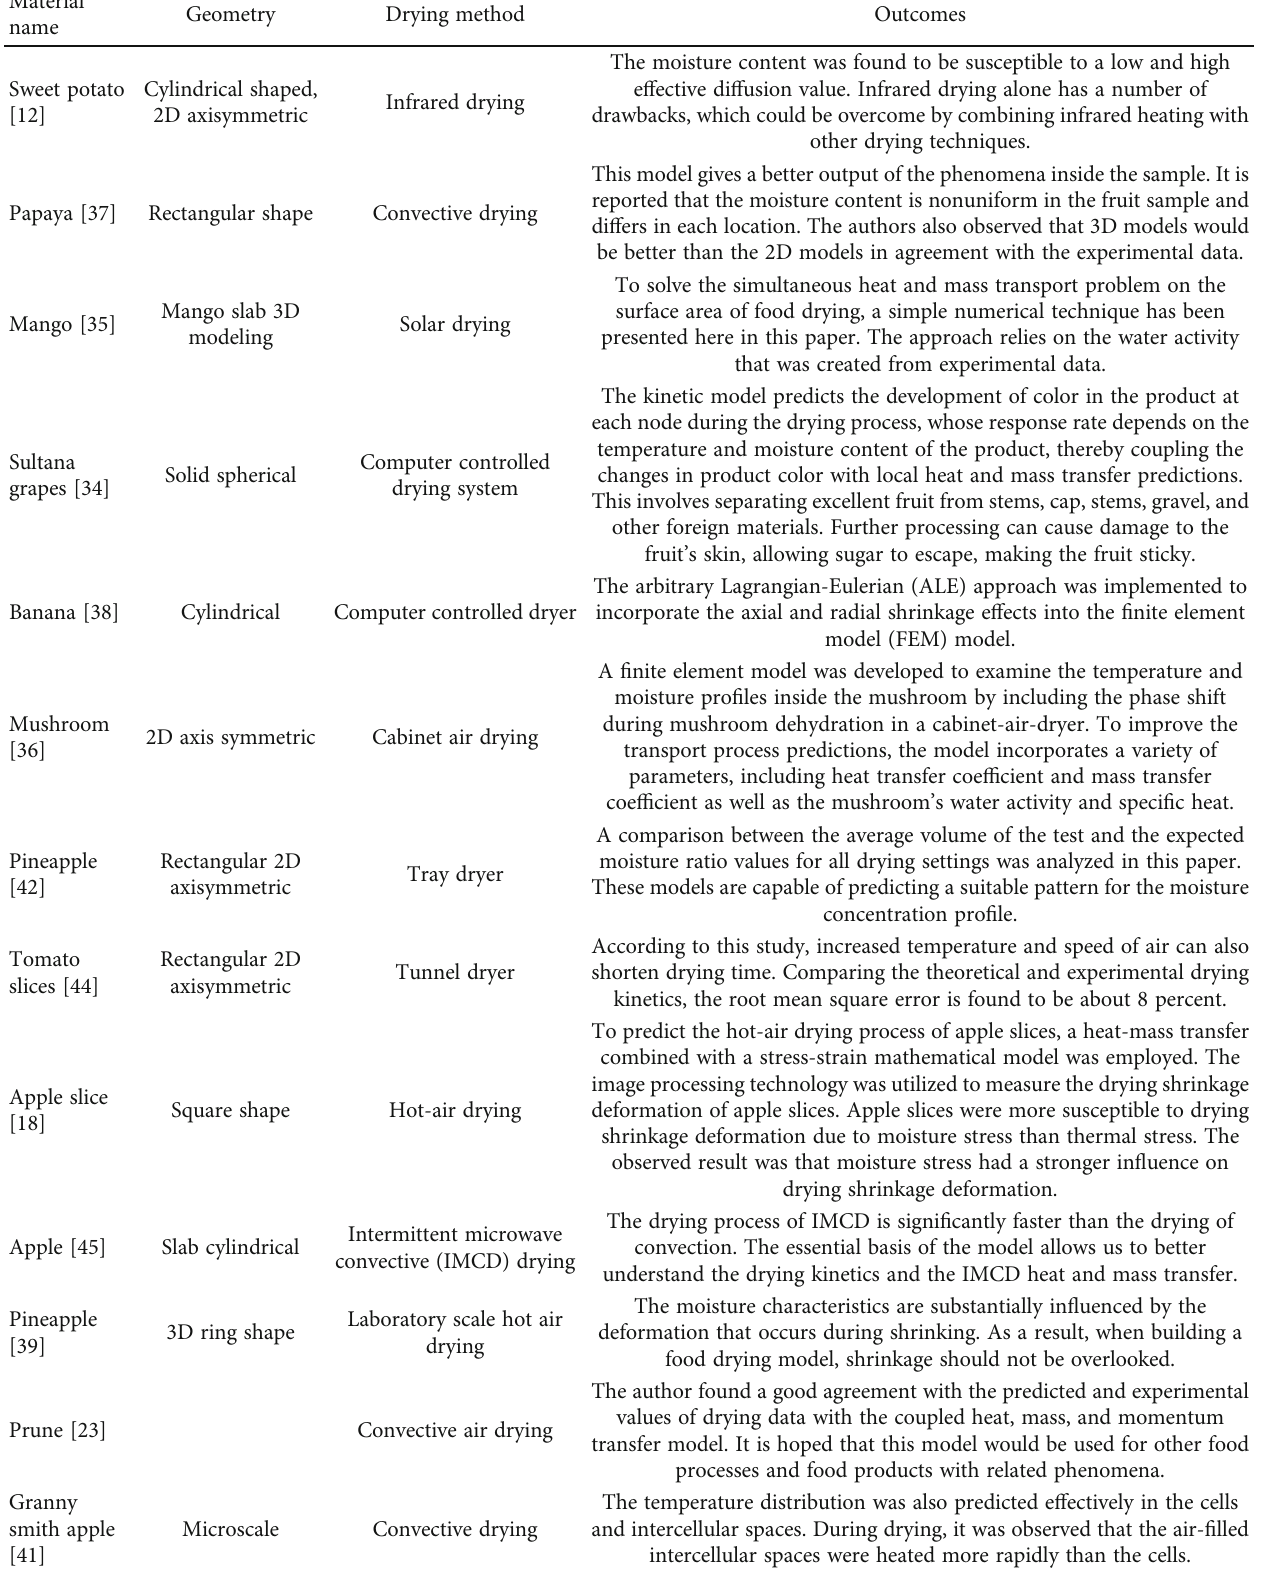
Table 3: Applications of theoretical